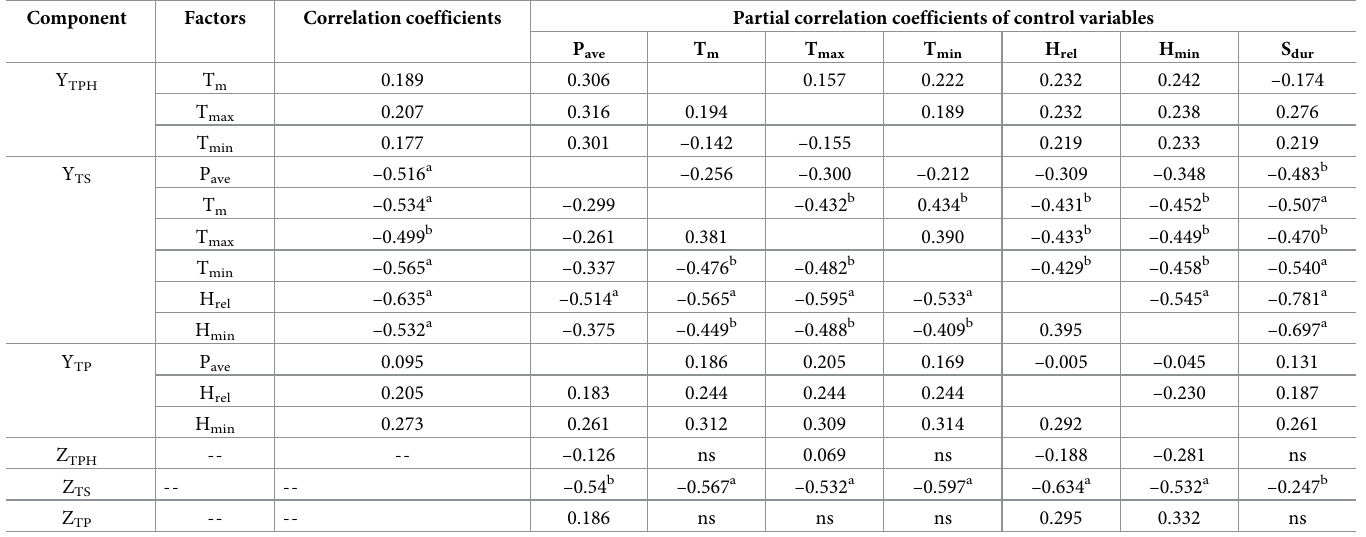
Table 3. Pearson correlation analysis among DPPH radical scavenging rates and contents of metabolites and climatic factors.